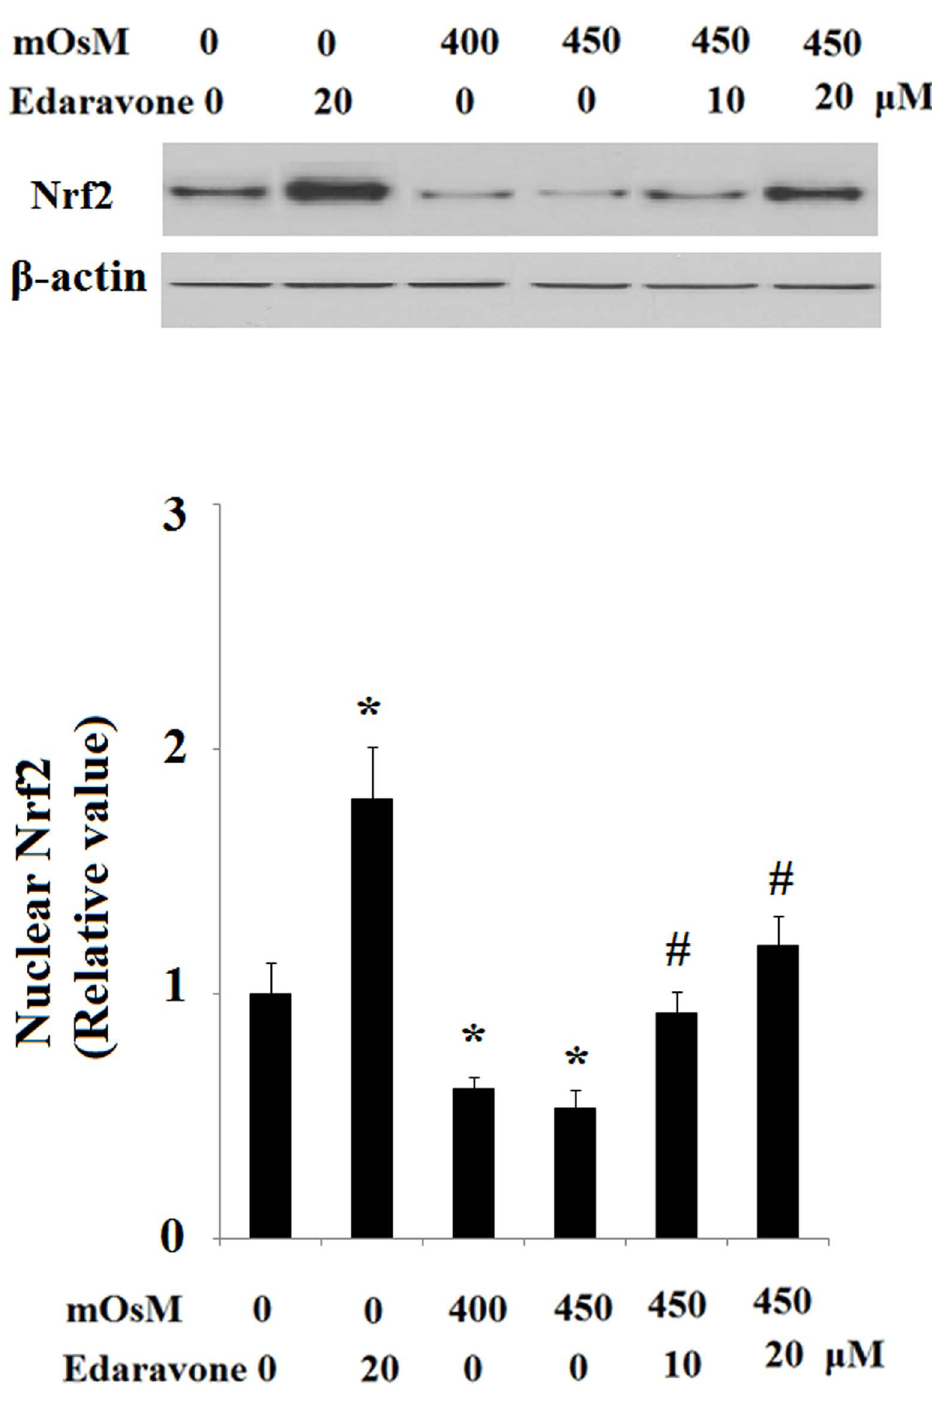
Fig 8. Effects of edaravone on the expression of Nrf2. Levels of Nrf2 in whole cell extracts were determined by the western blot analysis(ANOVA: * , P < 0.001vs. non-treatmentcontrol; #, P < 0.001vs. 450 mOsM treated